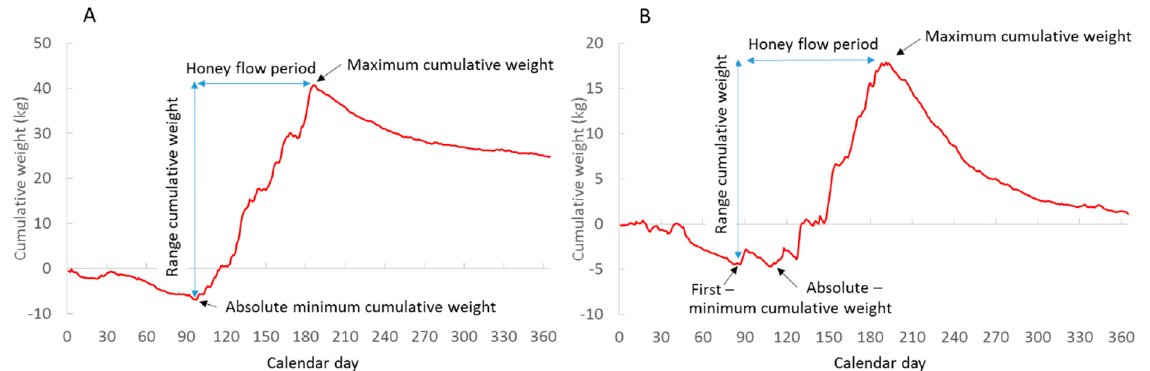
Figure 1. Cumulative forage curves showing a standard curve ( A ) with a single absolute minimum cumulative weight (Germany 2015) and ( B ) a curve with a first minimum that differs from the absolute minimum (Germany 2021).